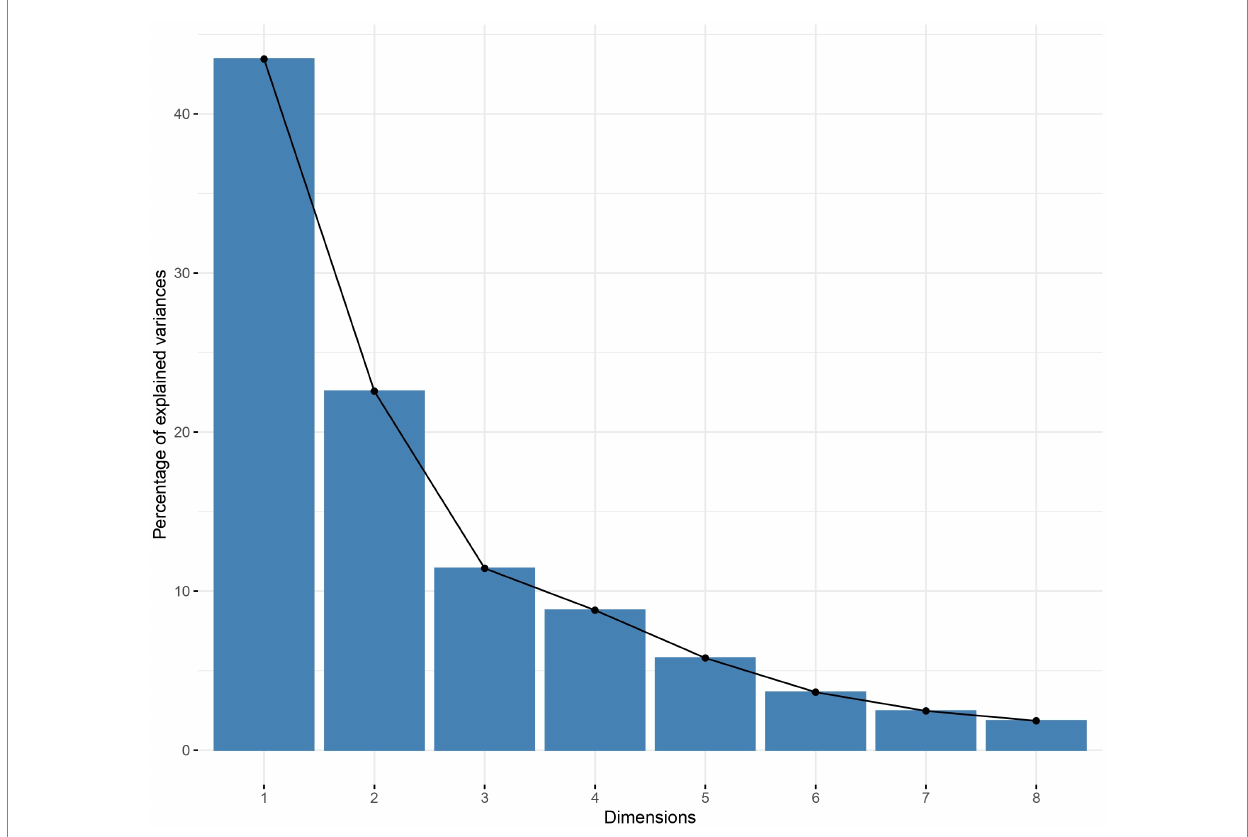
FIGURE 2 Principal component analysis Explained variance by dimension Using the maximum explained variance as a criterion, the horizontal axis is the individual dimensions and the vertical axis is the explained variance. It can be seen that the explained variance of the first dimension reaches more than 40 percent, the explained variance of the second dimension has more than 20 percent, and the explained variance of the first three dimensions reaches more than 75